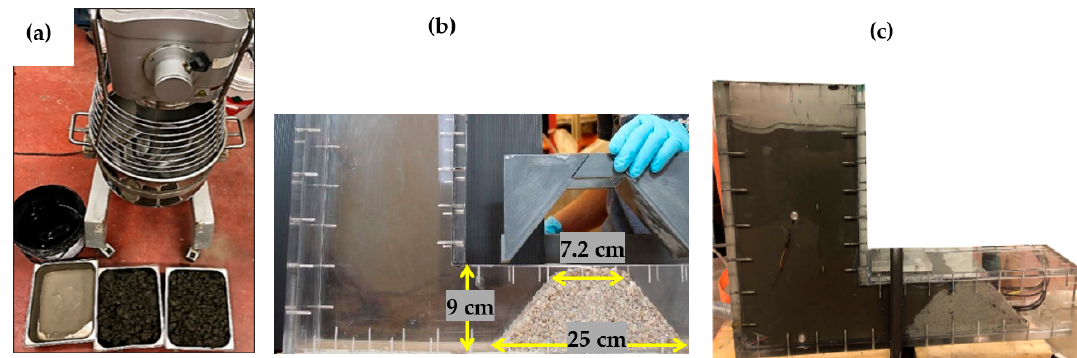
Figure 4. Experimental protocol: ( a ) paste backfill mixture preparation using a Hobart mixer and backfill ingredients (water, tailings, and binder), ( b ) setting up the barricade in the drawpoint, and ( c ) the first layer of the backfill after pouring and self-weight consolidation took place.